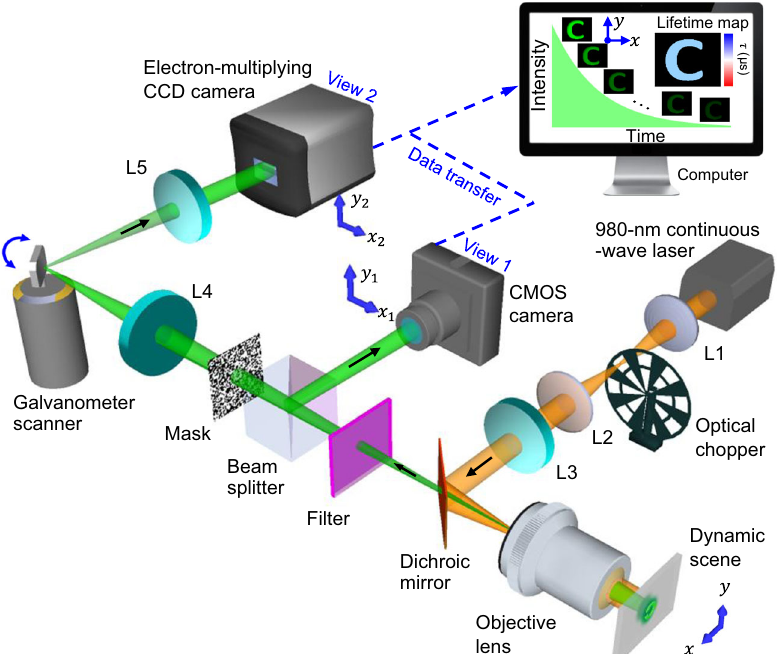
Fig. 1 Schematic of the SPLIT system. The illustration shows data acquisition and image reconstruction of luminescence intensity decay in a letter “ C ” . L1 – L5,